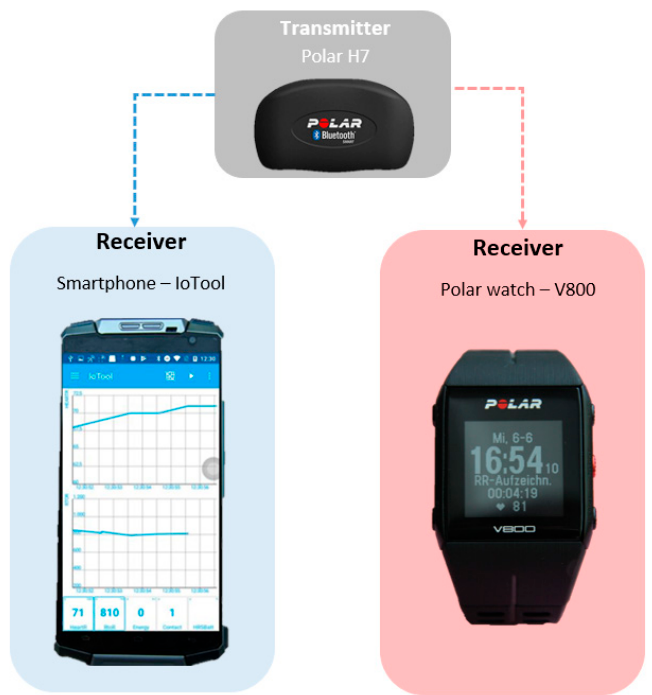
Figure 1. Dairy Cow I equipped with the Polar equestrian chest belt and Polar H7 receiver; red circles mark the placement of the electrodes.